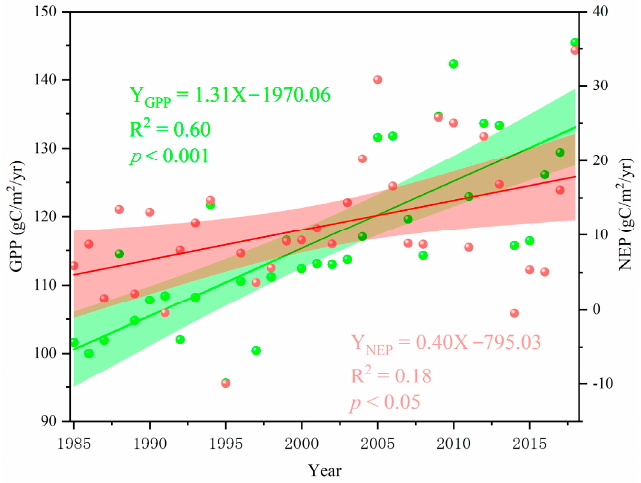
Figure 4. Trends of GPP (green line) and NEP (red line) in the TRSR from 1985 to 2018. Table 4. Alpine grassland trends in the TRSR and its subregions.